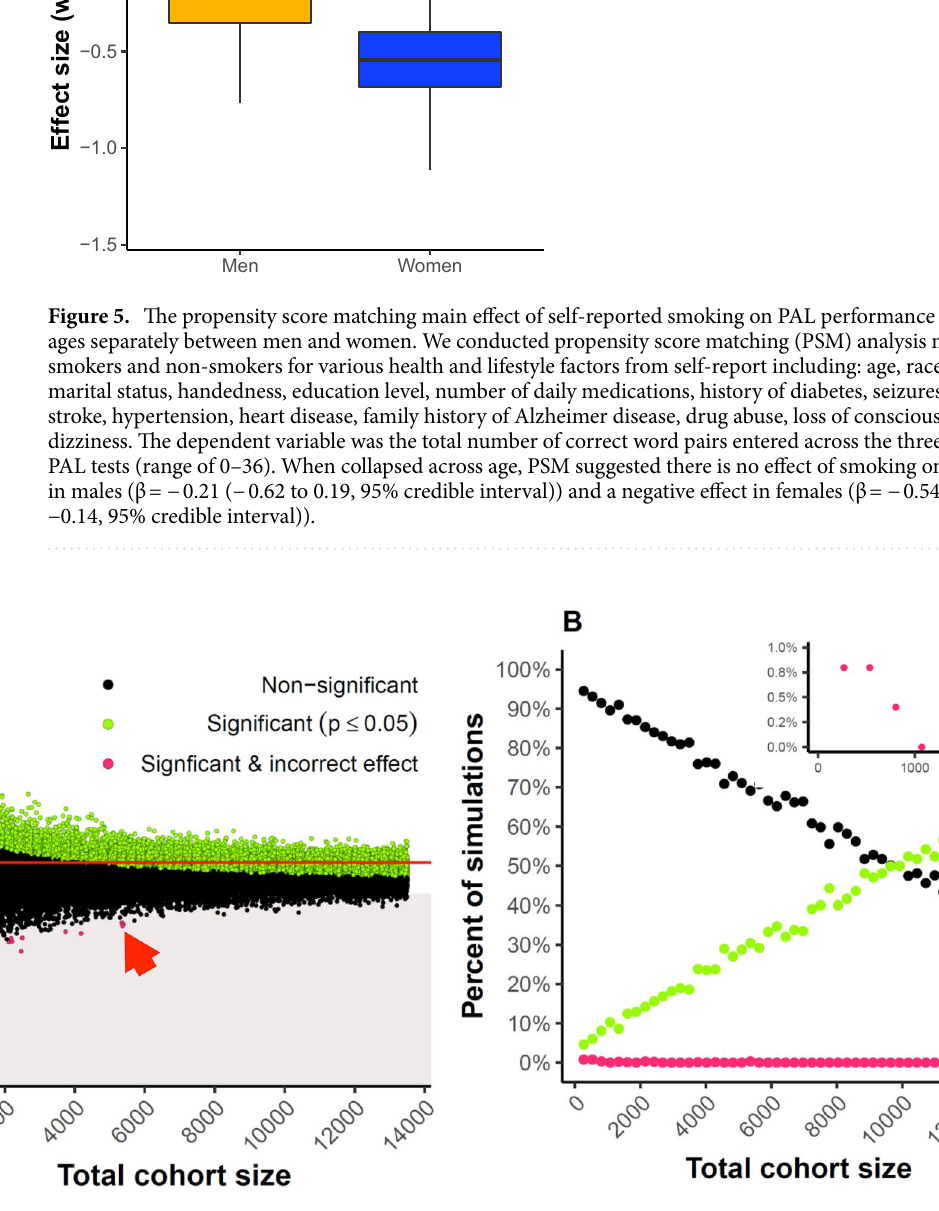
Figure 6. ( A ) We conducted 1000 down-sample linear regression models of the MindCrowd cohort between the ages of 18 and 85 years for the interaction effect (β, y axis) of sex × smoking on paired associate learning (PAL) for each indicated total sample size (x axis). For each analysis, we had an equal amount of smokers and non-smokers and women and men. The horizontal red line indicates the effect size estimated by the total study sample. Green filled circles indicate an individual down-sampled comparison that resulted in a statistically significant association ( p < 0.05), black dots are non-significant comparisons. Red arrow highlights that at samples sizes approximating 5000 one could potentially produce a significant beta value with the opposite sign from the largest sampled model. ( B ) is the same data displayed to easily see the positive relationship between significant betas and sample